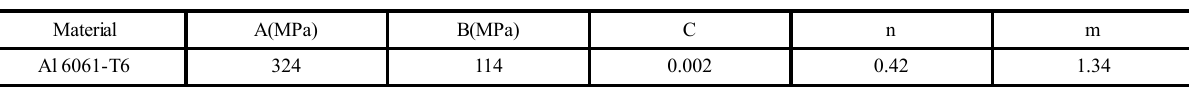
TABLE 4. JOHNSON-COOKOK MATERIAL MODEL CONSTANTS FOR AL 60616 –T ALLOY [6,25,40]